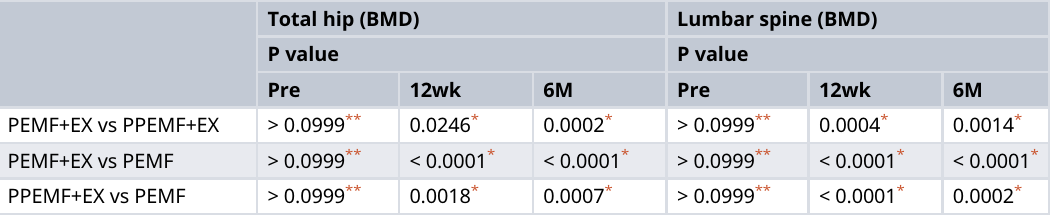
Table 4. Comparison between each measurement interval among treatment